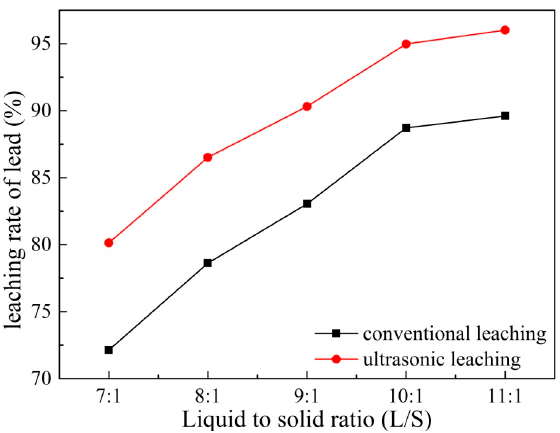
Figure 9. E ff ects of liquid to solid ratio on leaching of Pb. Figure 9. Effects of liquid to solid ratio on leaching of Pb.